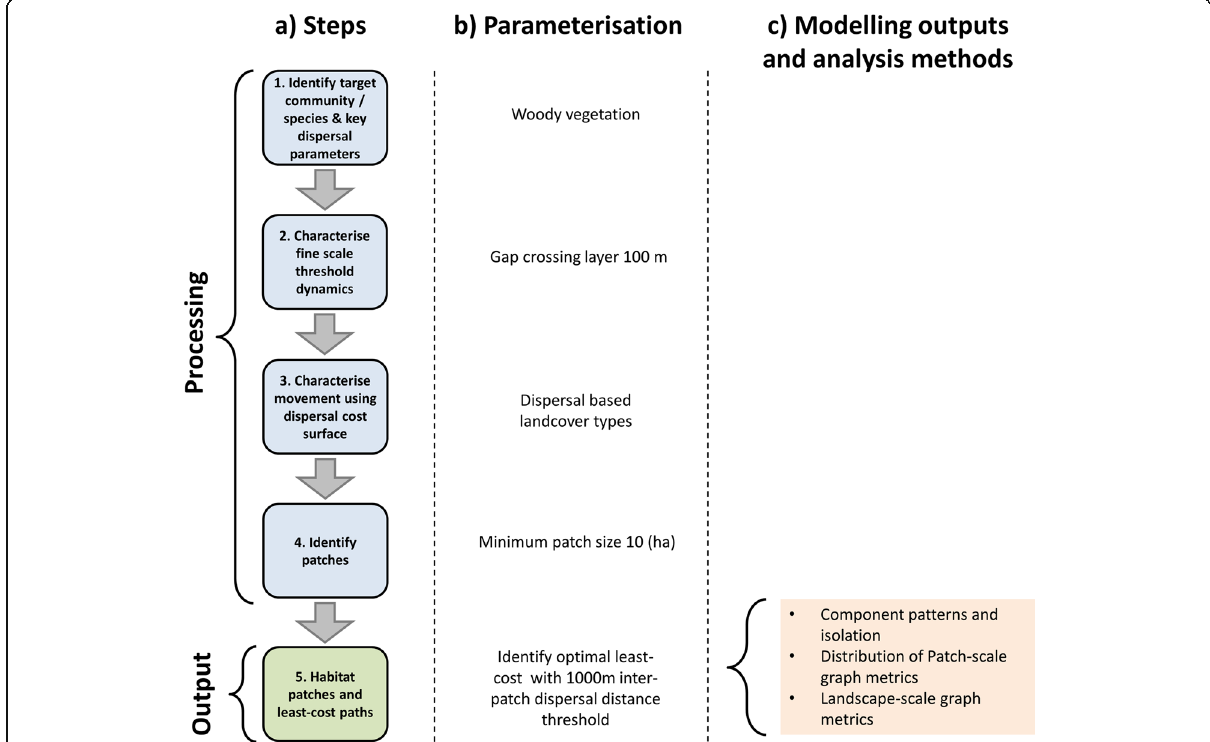
Fig. 1 Flow diagram describing the workflow of connectivity assessment of the Karuah-Myall